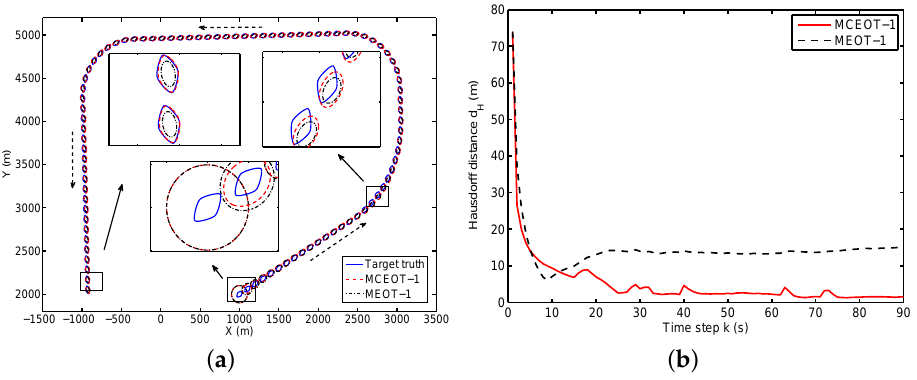
Figure 8. Simulation results in scenario A. ( a ) the object trajectory; ( b ) Hausdorff